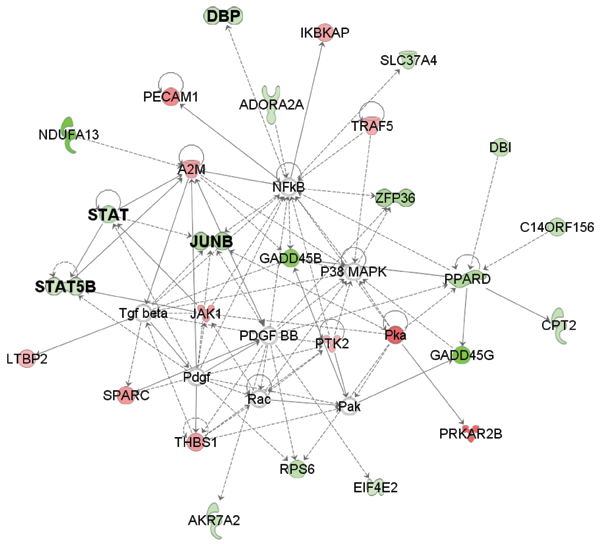
Ingenuity pathway analysis on NFκB related gene network. Green and red nodes represent repressed and induced genes in androgen-independent prostate samples comparing androgen-dependent prostate samples, respectively.